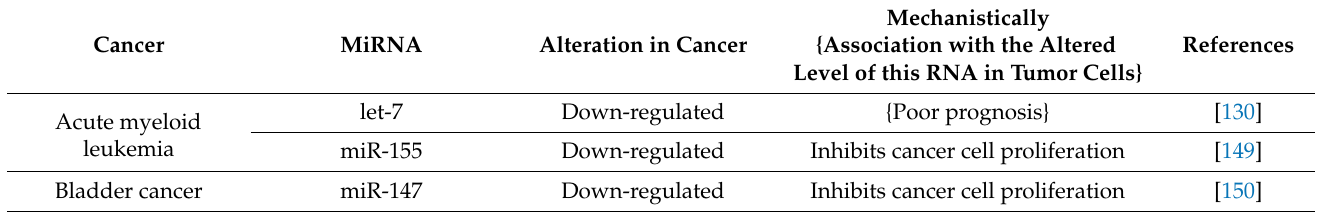
Table 1. miRNAs that control the expression of the MYC gene in tumors of various human organs. Cancer MiRNA Alteration in Cancer